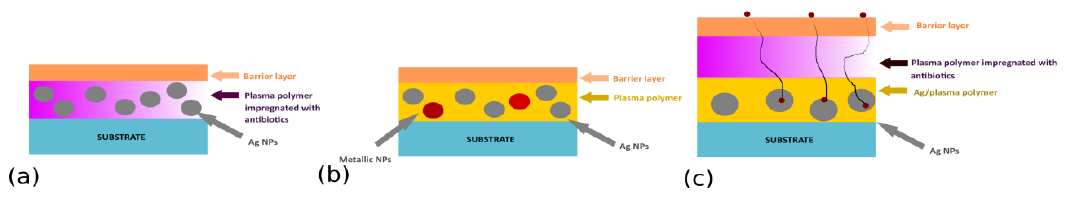
Figure 8. Different architectures suggested for multi-release coatings.